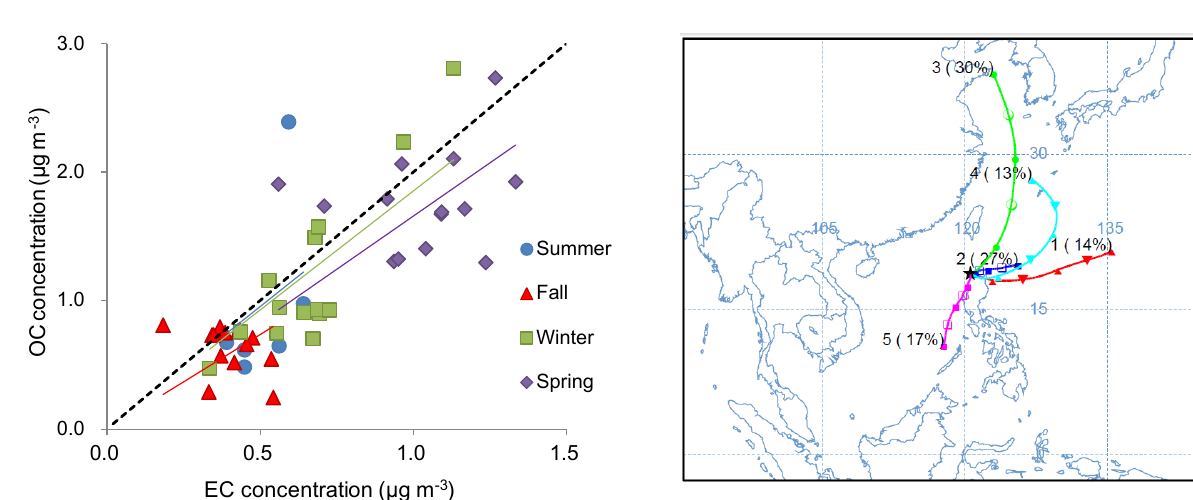
Figure 5. Scatter plot of OC and EC for summer, fall, winter and spring sampling period (in µgm − 3 ). Bold dashed line indicates OC / EC ratio of 2.